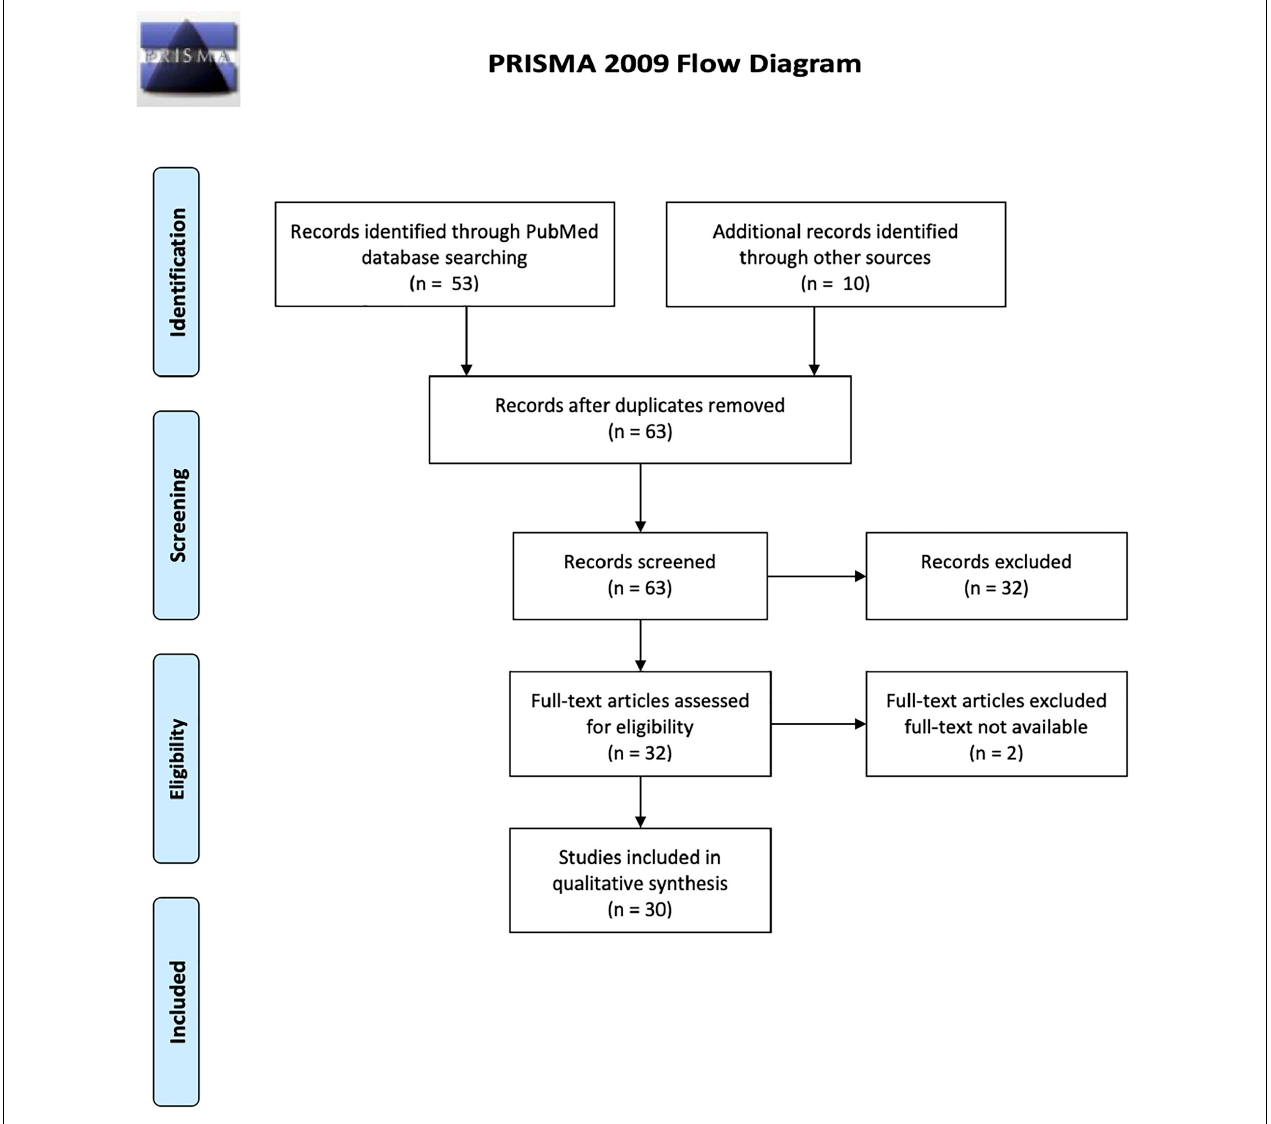
FIGURE 1 | PRISMA diagram describing selection of studies for the